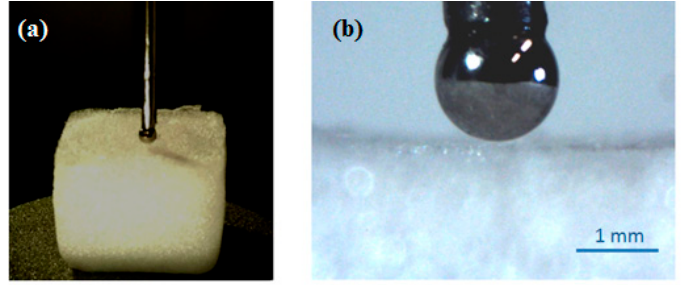
Figure 9. Micro-indentation tests performed on HEMOCOLLAGENE ® foam. ( a ) Global view of the indentation test on a typical specimen (10 × 10 × 10 mm); ( b ) Zoom of the spherical indenter (radius = 0.75 mm).